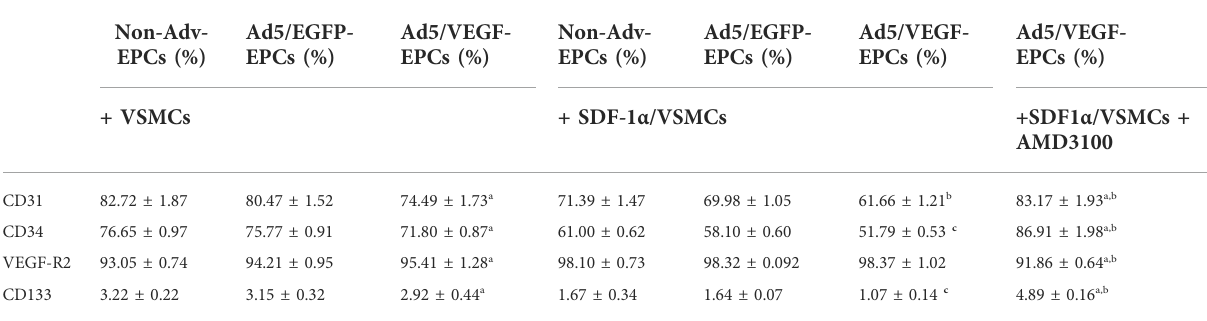
TABLE 1 Positive staining of EPC surface